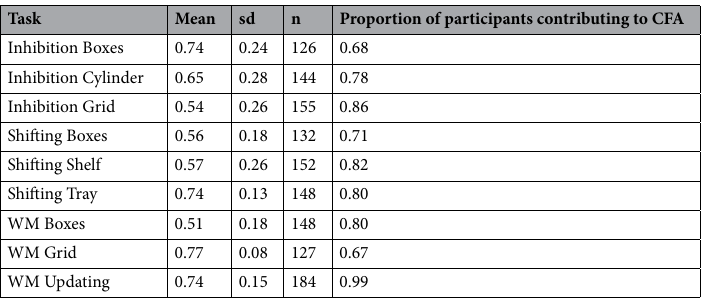
Table 2. Descriptive statistics for the nine executive functions tasks for the entire child sample group (N = 190).